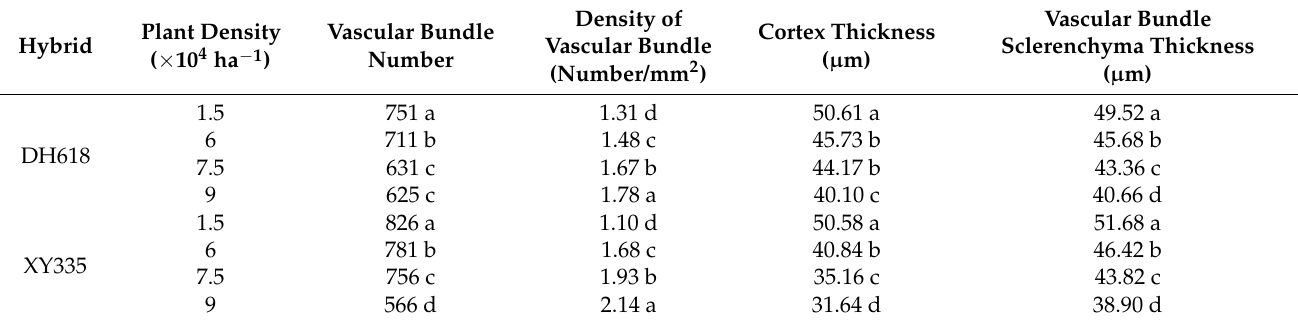
Table 7. Stem micro-structure of DH618 and XY335 under different planting densities in